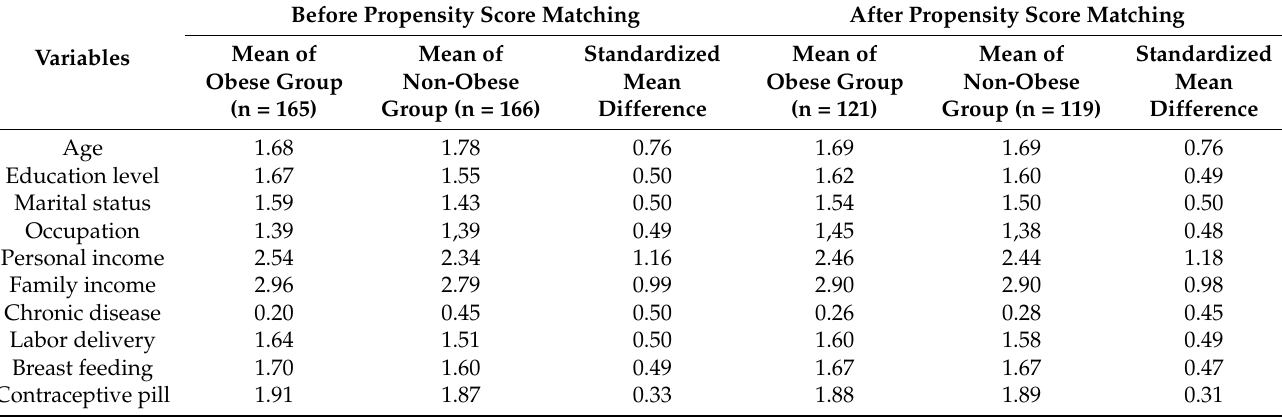
Table 1. Data balance after propensity score matching.